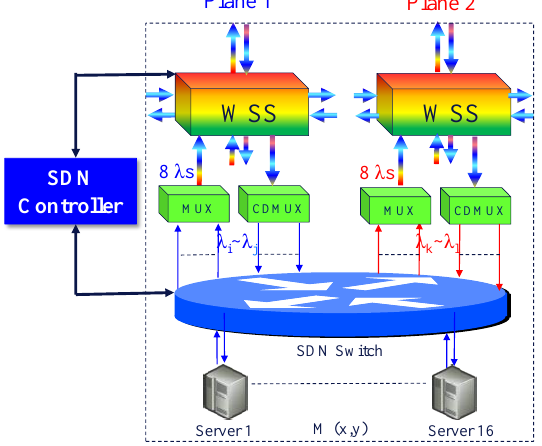
Figure 5. A module of two-plane Torus topology optical tunnel switching network.